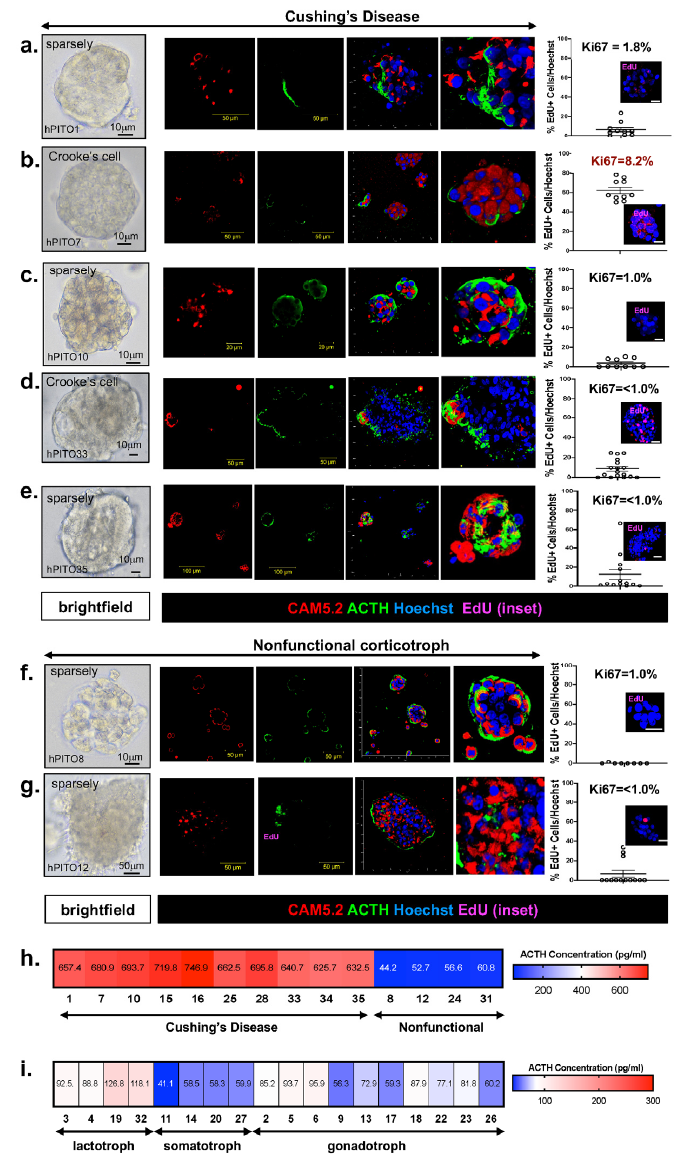
Figure 1. Morphology and function of corticotroph hPITOs. ( a – g ) Brightfield images, immunofluo- rescence staining using antibodies specific for CAM5.2 (red), ACTH (green), and EdU (magenta, inset) of organoid cultures generated from patients with Cushing’s disease (hPITOs 1, 7, 10, 33, 35) or nonfunctional corticotroph adenomas (hPITO8, 12). Quantification of %EdU positive